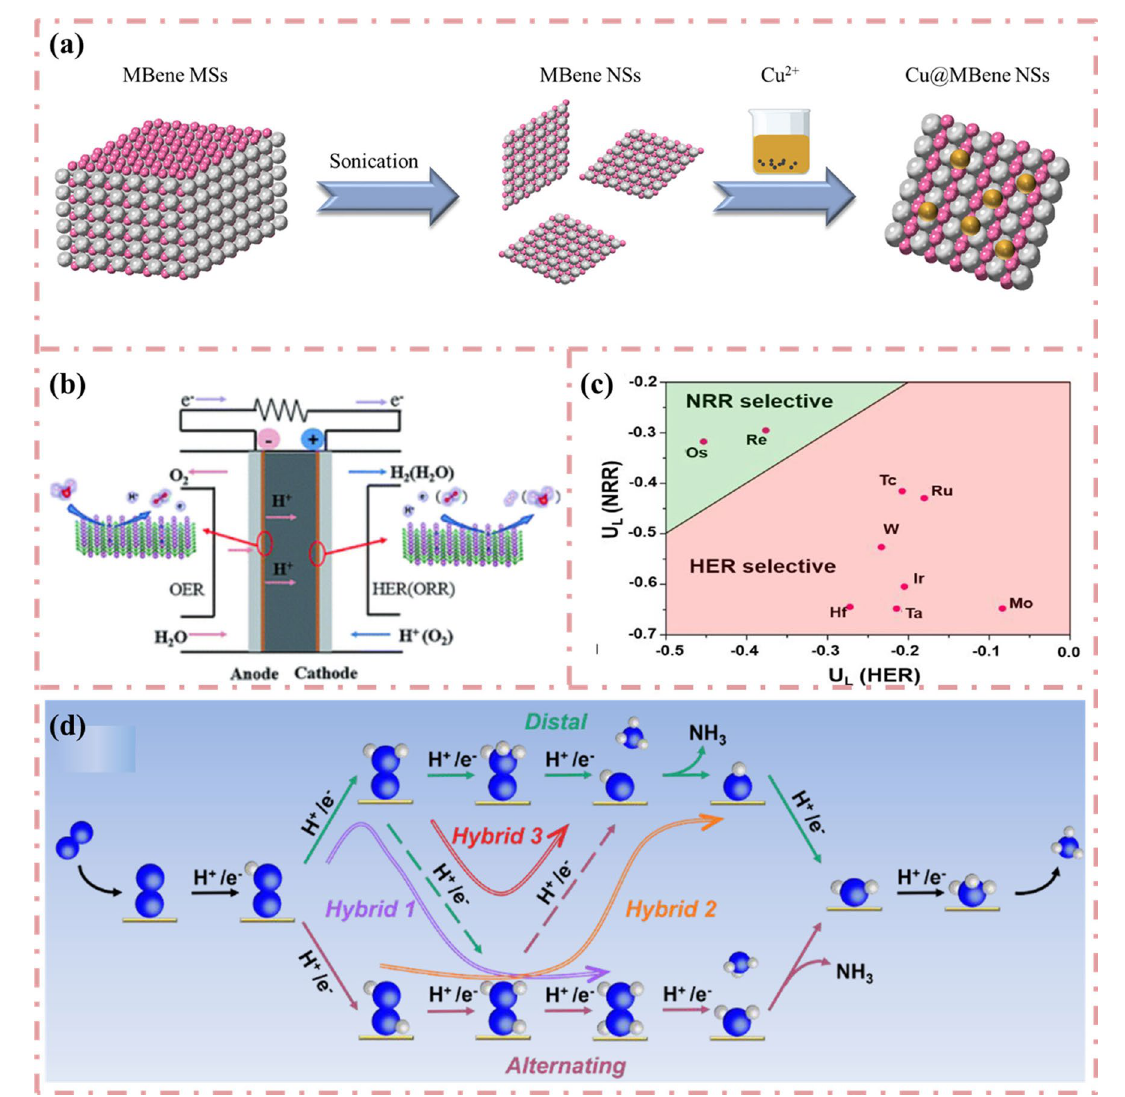
Fig. 15 a A schematic formation mechanism of the Cu@MBene NSs. b Schematic illustration of the process of water splitting. Reproduced with permission from Ref. [218]. c The calculated potential vs SHE for HER ( U *H ) and NRR ( U *NNH ) for selectivity screening. d Schematic of the possible five routes (the distal, alternating, hybrid 1, hybrid 2 and hybrid 3) for eNRR over Mo 2 B 2 O 2 -SA systems. Reproduced with permis- sion from Ref.